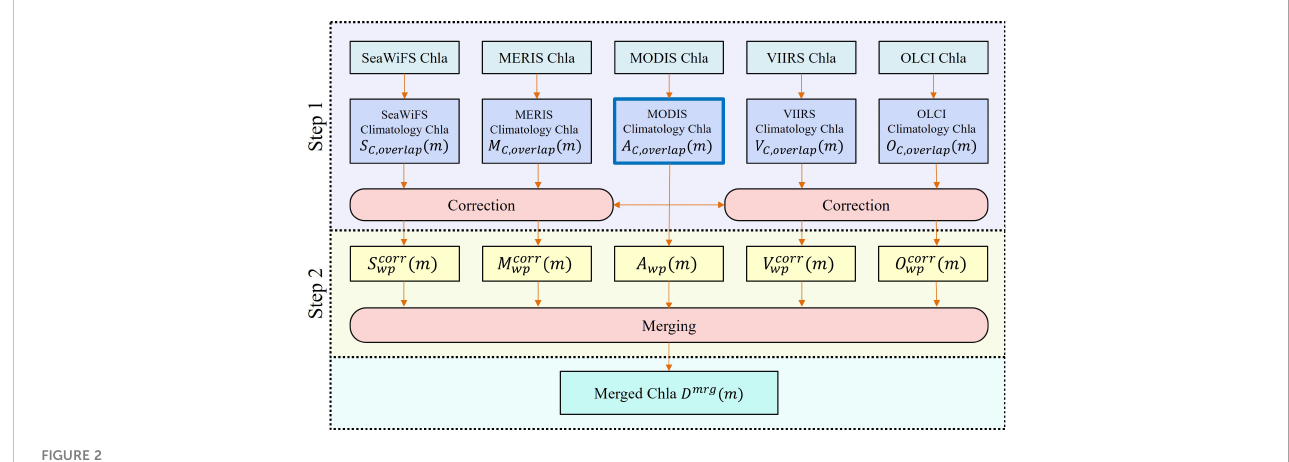
FIGURE 2 The procedure of multiple sensors Chla data